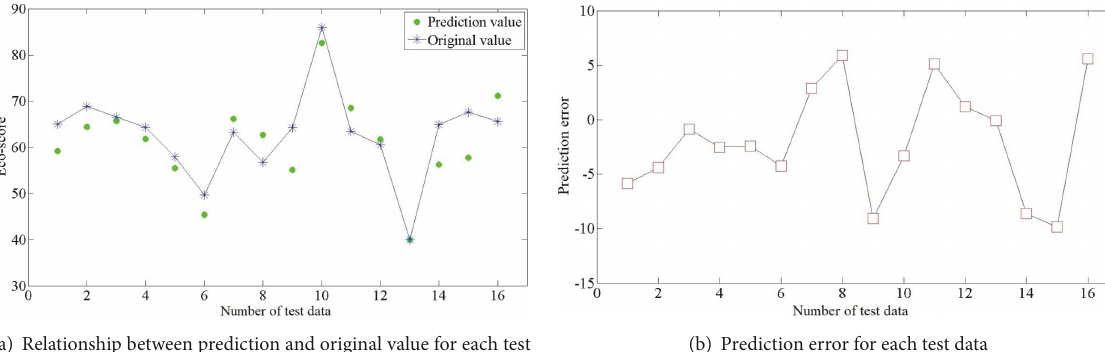
Figure 7: Accuracy test results of ecolevel estimation